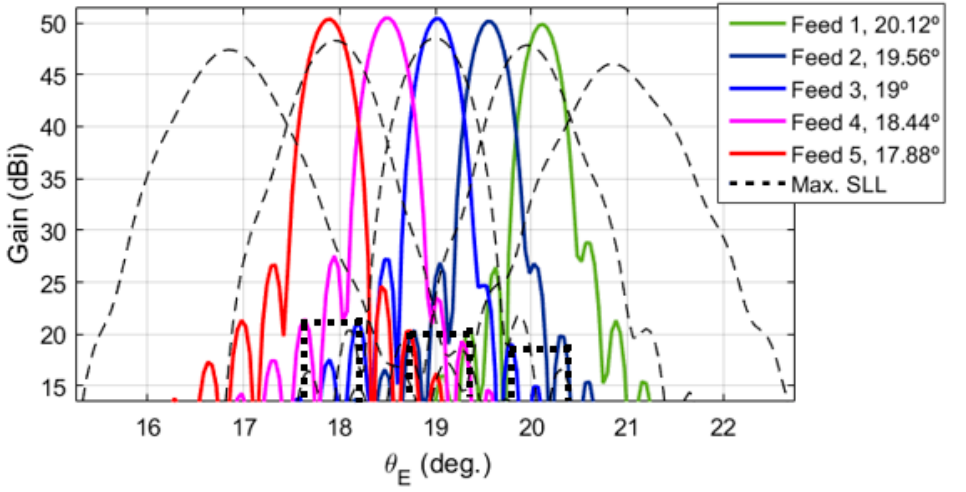
Figure 6. Simulated radiation patterns at 20 GHz in the xz -plane of the beams generated by the bifocal DRAA (solid colored lines) and the beams produced by the equivalent monofocal DRAA (dashed lines), indicating the maximum side-lobe levels (SLL, in black dotted lines) that produce the interference among reuse beams (see Section 5).